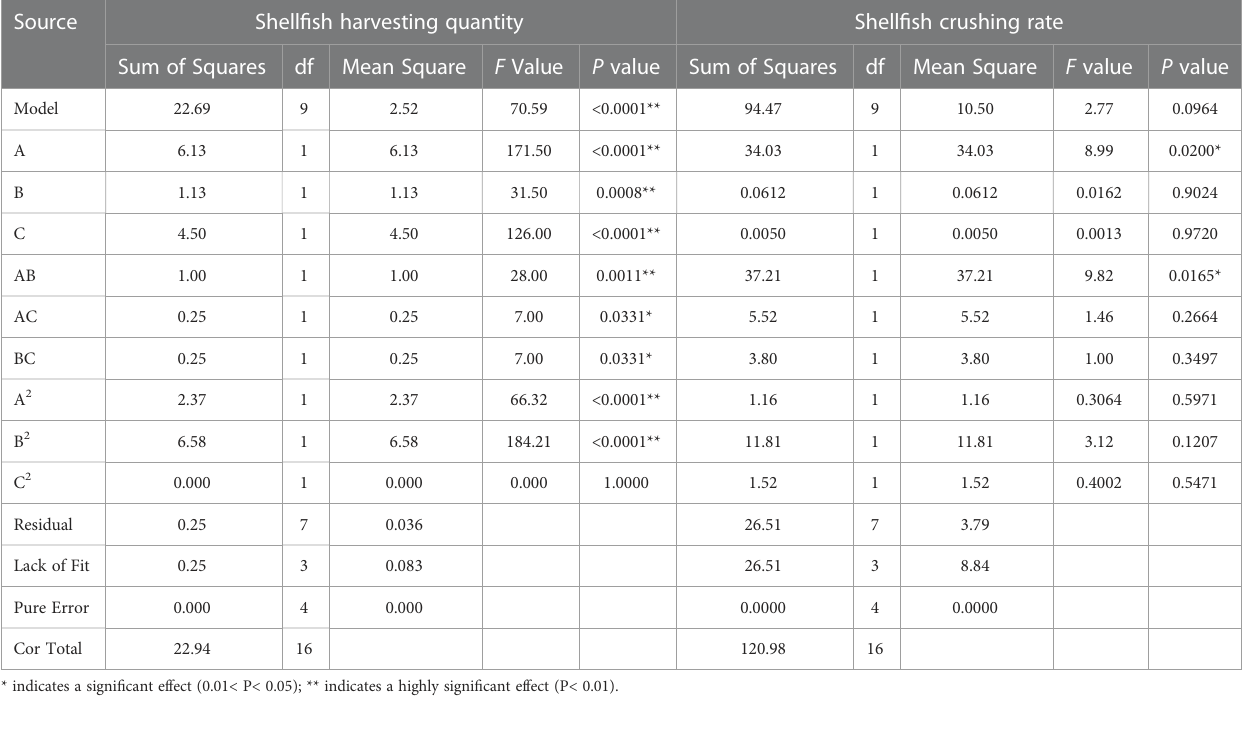
TABLE 6 ANOVA results of factors in fl uencing shell fi sh harvesting quantity and shell fi sh crushing rate. Source Shell fi sh harvesting